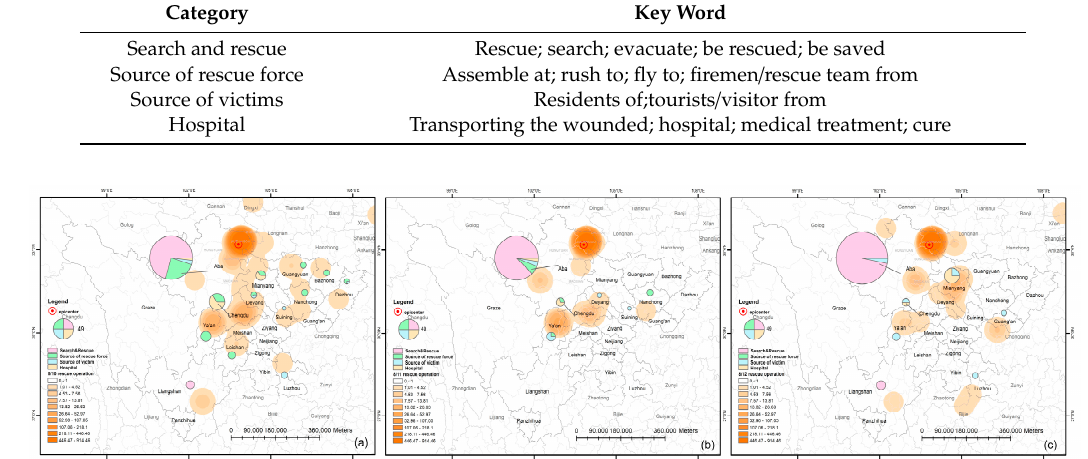
Figure 7. Spatial distribution of rescue microblogs. ( a – c ) Spatial distribution of rescue microblogs on 10 to 12 August, with a darker color indicating more rescue microblogs. Pie charts show the types and numbers of rescue microblogs in different prefecture-level cities. ISPRS Int. J. Geo-Inf. 2019 , 8 , x FOR PEER REVIEW Table 4. Rescue microblog categories and keywords.